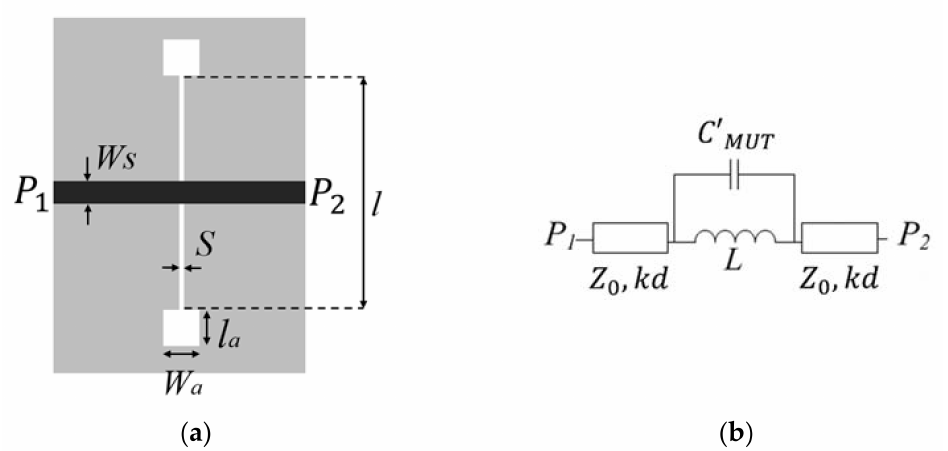
Figure 1. Typical topology ( a ) and equivalent circuit model ( b ) of a DB-DGS-loaded microstrip line. Relevant dimensions are indicated. The strip of the line is indicated in black color, whereas the ground plane where the DB-DGS resonator is etched, is depicted in grey color. In ( b ), the resonant tank accounts for the DB-DGS resonator, whereas the line sections of characteristic impedance Z 0 and electrical length kd , describe the pair of lines between the ports (P1 and P2) and the position where the resonator is etched ( k is the phase constant and d is the length of these line